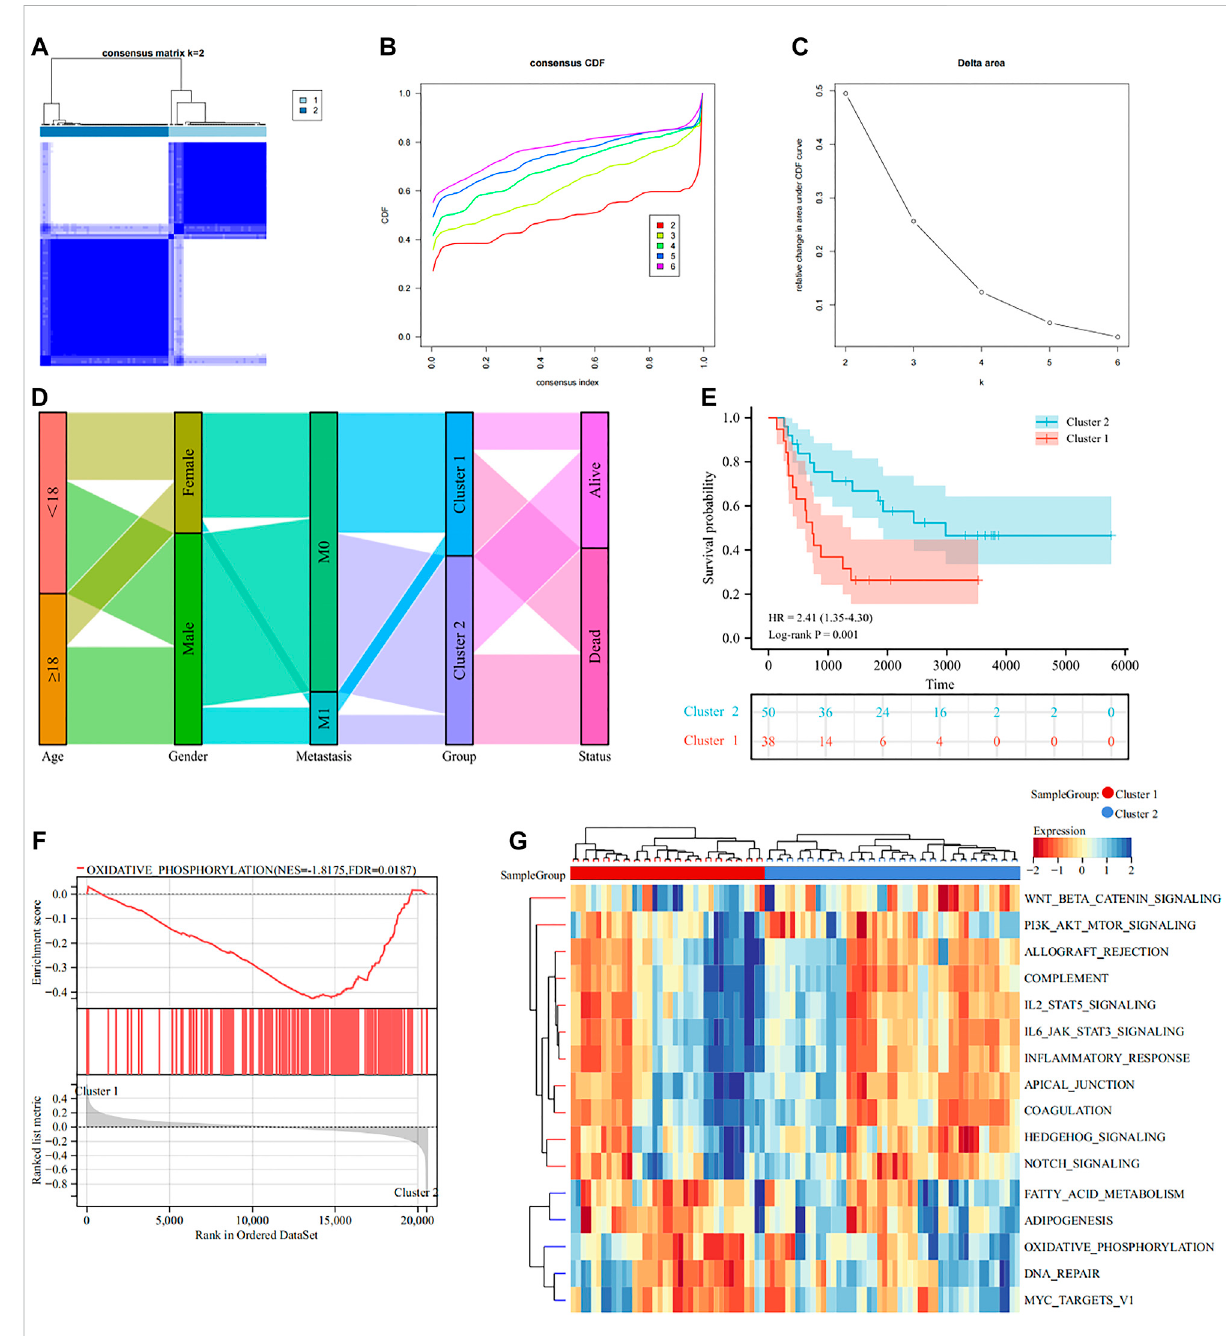
FIGURE 3 Classi fi cation of lactate modulation patterns by clustering analysis (A – C) . K = 2 was regarded as the optimal number of subtype clusters (D) . Sankey diagram showing the association of different patterns with clinical features (E) . KM curve presenting the prognosis of different patterns (F) . GSEA analysis showcasing different patterns of hallmark gene sets (G) . GSVA analysis exhibiting the functional enrichment of different